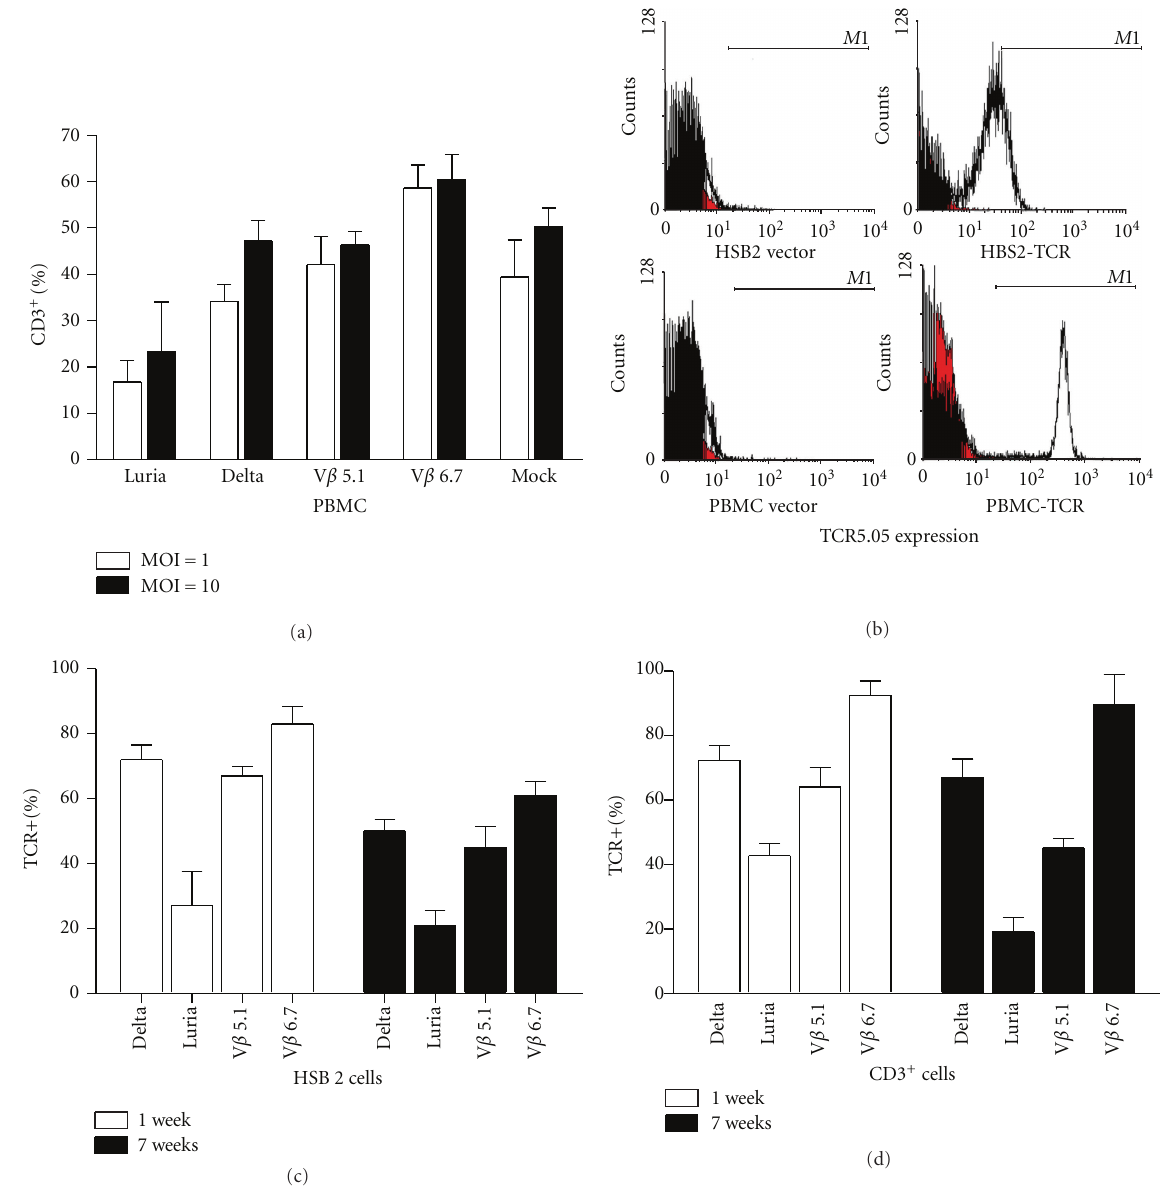
Figure 3: Expression of TCR α and β chains in the HSB2 cells and PBMCs. (a) The PBMCs were incubated with lentivirus containing EBV-LMP2 TCR α and β chains driven by T cell-specific promoters at MOIs of 1 and 10. Three days aftertransduction, cells were collected and stained for CD3 mobilization as a measure of TCR α chain expression. (b) Photographs of flow cytometric analysis for TCR α chain expression in HSB2 cells (top) and PBMC cells (bottom). The cells were infected with recombinant lentivirus or control empty lentivirus at MOI of 10 for 3 days. TCR staining was performed by using anti-TCR α chain antibody (prepared from our lab) followed by PE-labeled second antibody. (c) Percentage of TCR α chain-positive cells in transduced HSB2 cells 1 week and 7 weeks after infection at MOI of 10. (d) Percentage of TCR α chain-positive cells in transduced CD3 + cells 1 week and 7 weeks after infection. PBMCs stimulated with IL-2 plus OKT3 for 24 hr were infected with the lentivirus at an MOI of 10. After 1 week, the PBMCs were analyzed by FACS for TCR α chain expression and then maintained in culture with IL-2 for 7 weeks for reanalysis for TCR α chain-positive cells.